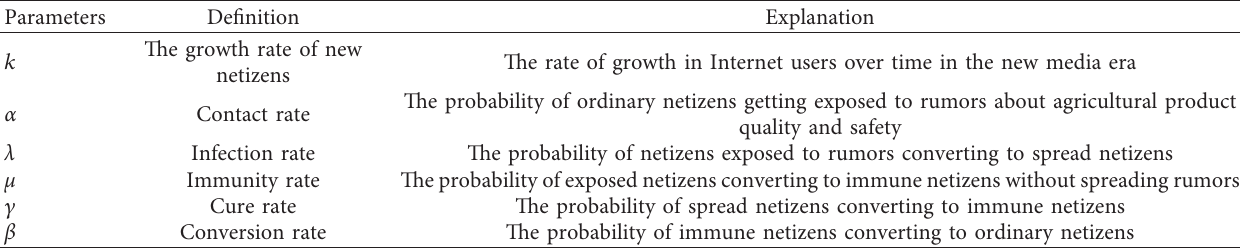
Table 1: The main parameters of the SEIRS model and their explanations.